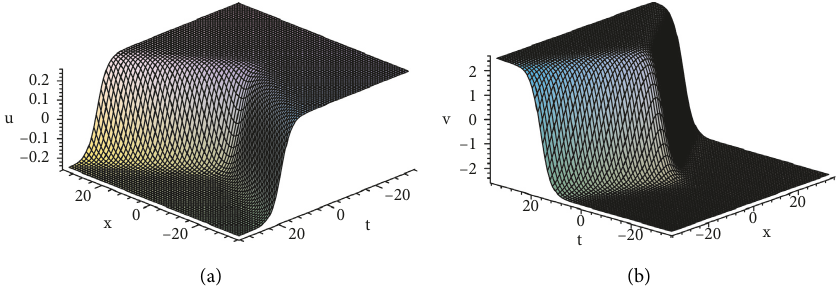
Figure 2: The propagation for u (gray) and v (bright) is plotted in (a) and (b),